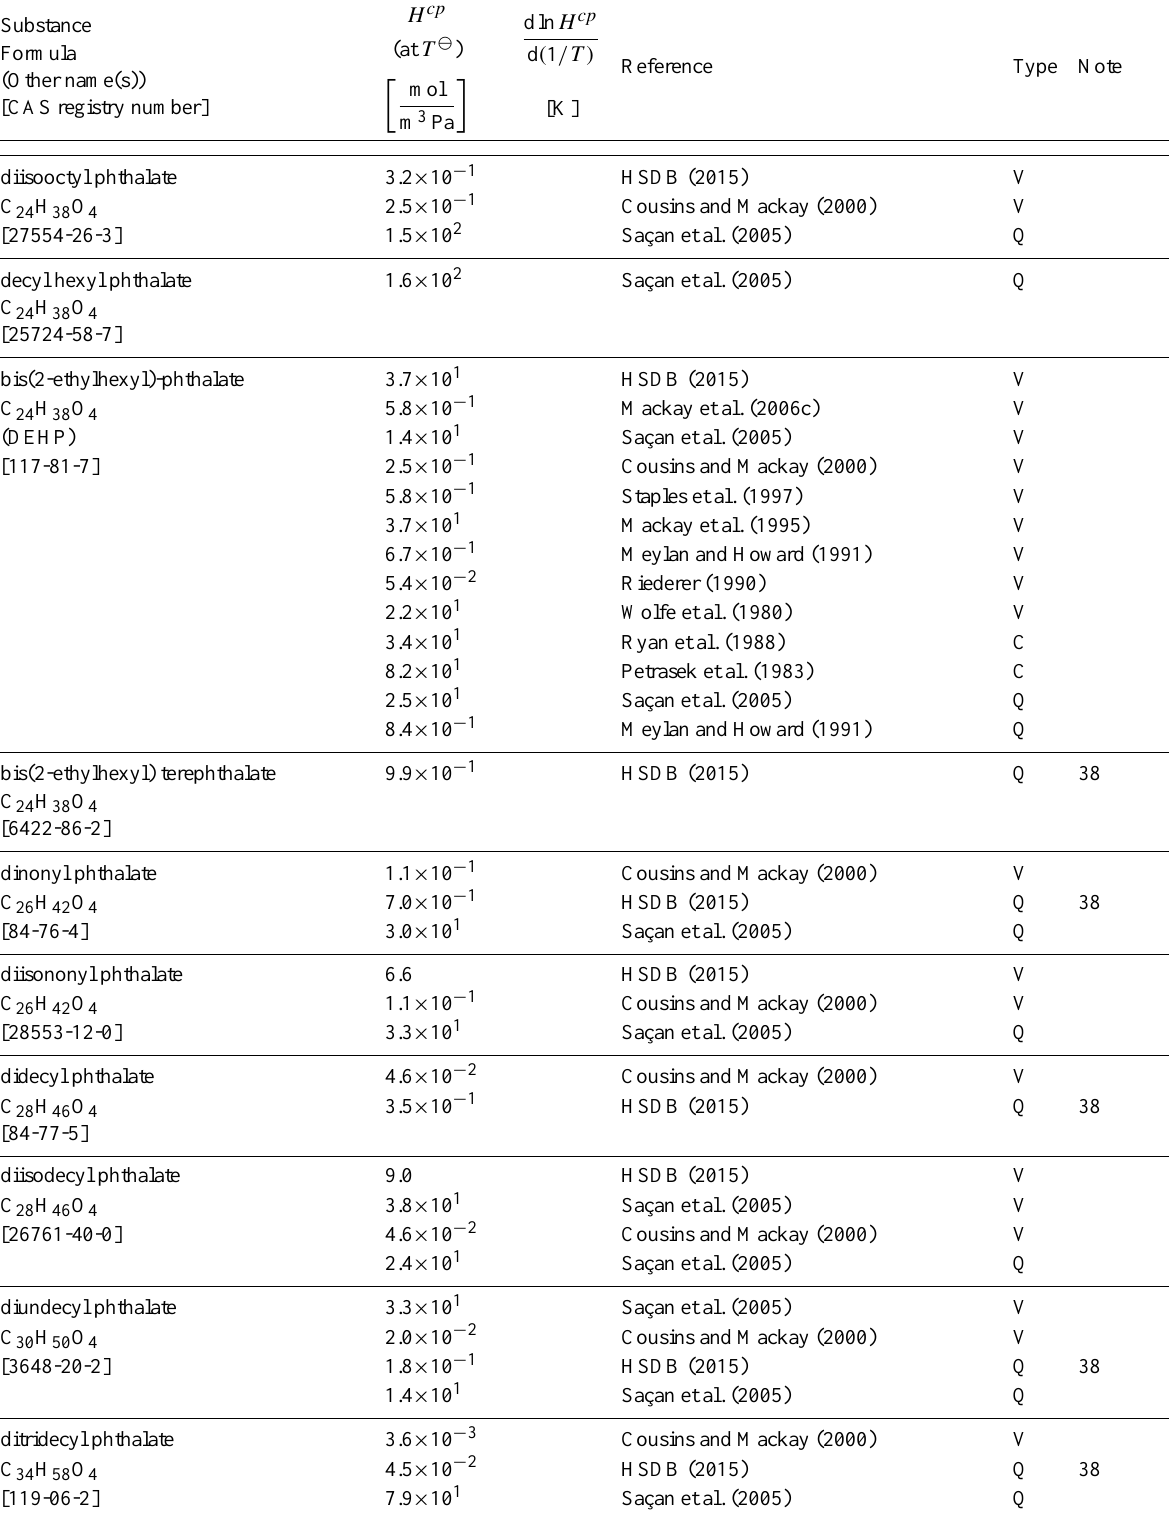
Table 6: Henry’s law constants for water as solvent